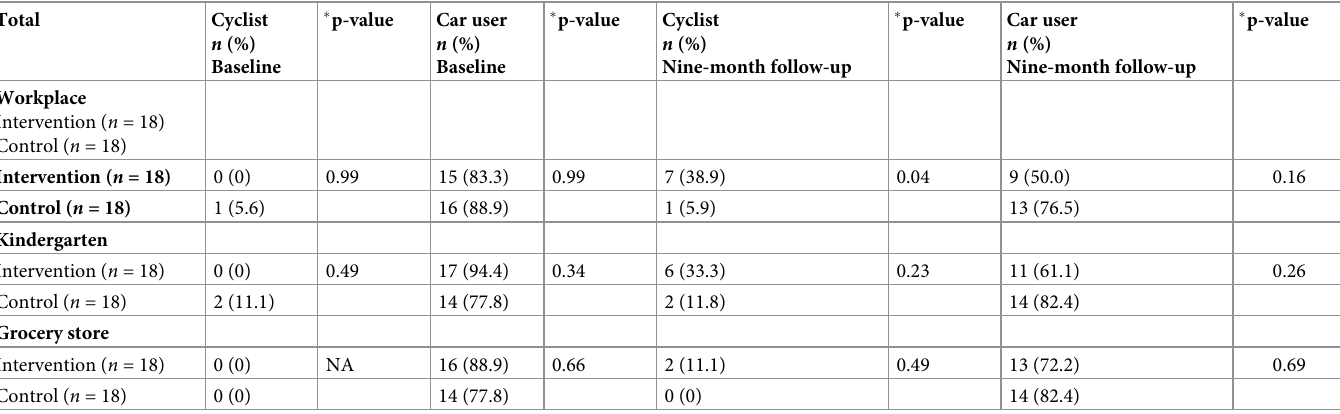
Table 2. Mode classification across intervention and control group